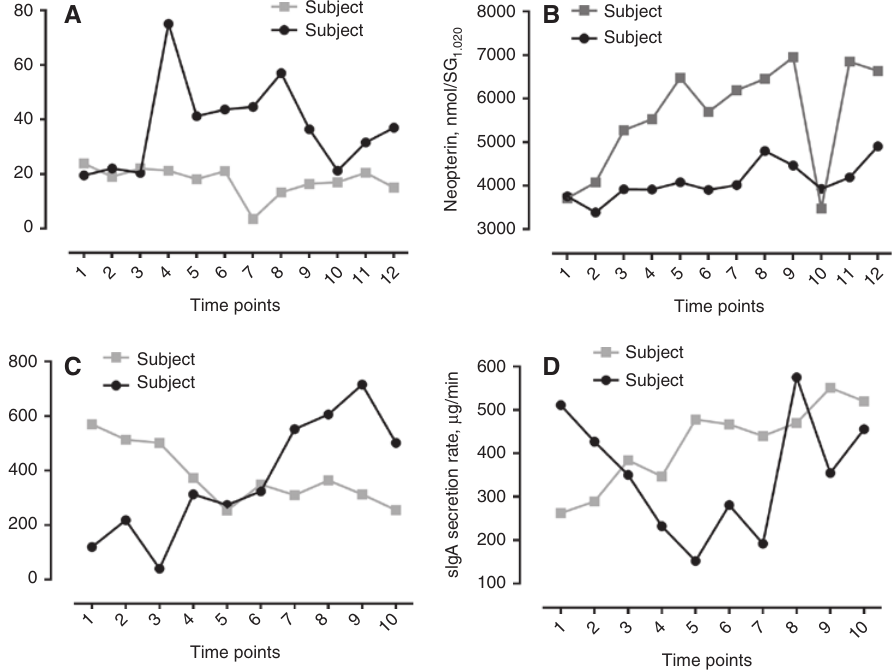
Figure 3: Longitudinal changes in cortisol (A), total neopterin (B), sIgA concentration (C) and secretion rate (D) of selected individuals who responded